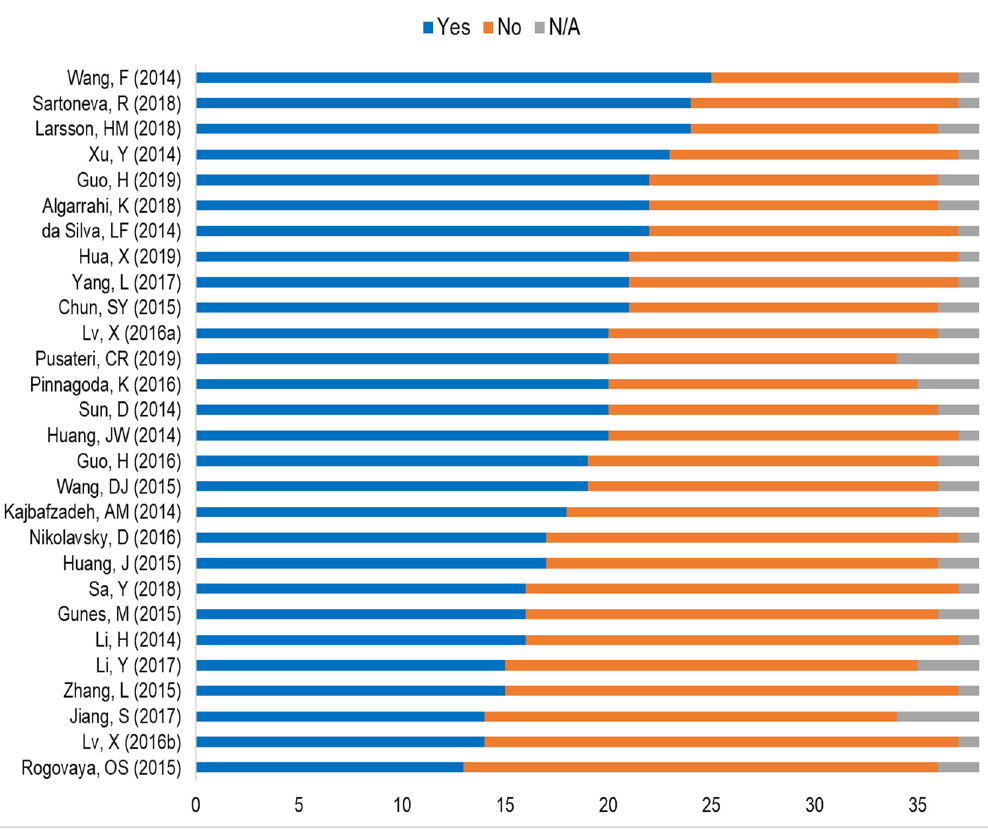
Figure 3. Bar chart displaying the scores of the analyzed articles. Scores represent the percentage adherence to the ARRIVE guidelines on a scale from 0 to 100.